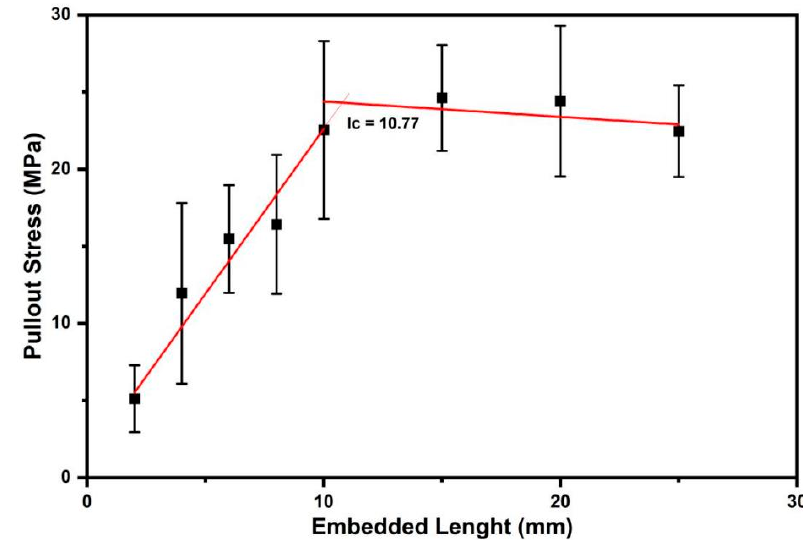
Figure 7. Comparison of pullout strength behavior with increasing embedded length of sedge fibers. From the linear stages shown in the plot in Figure 7 for tensile stress against embedded length, Equations (6) and (7) were adjusted.